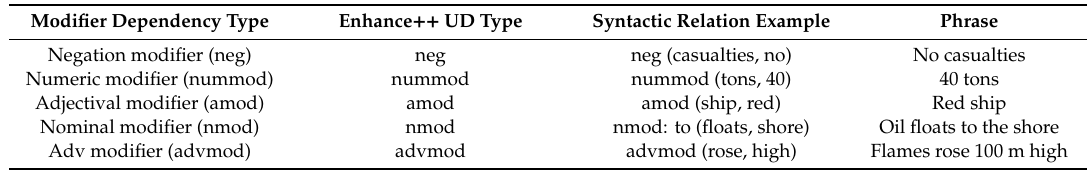
Table 3. Modifier dependence type.